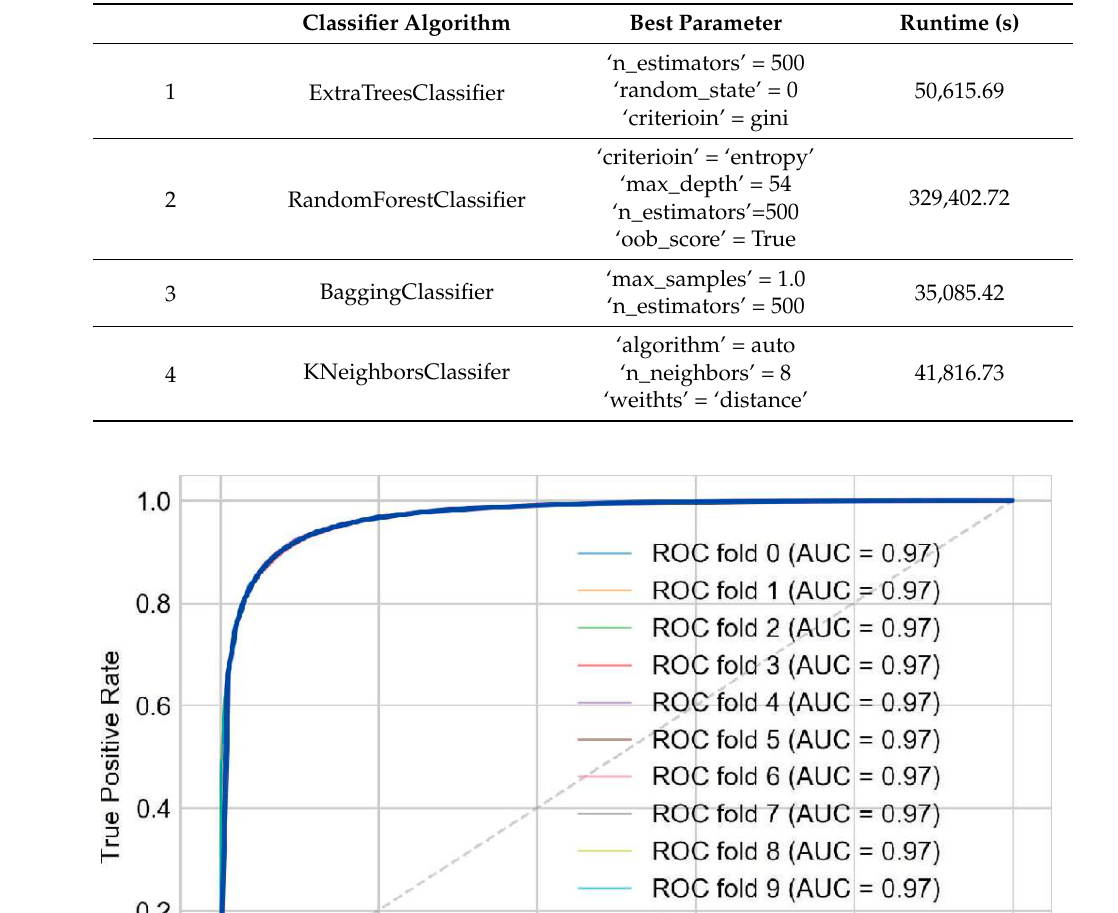
Table 3. Model optimal super parameter results and the time consumed. (Note: Please refer to the Scikit-learn website for the explanation of each parameter and its role in model adjustment: